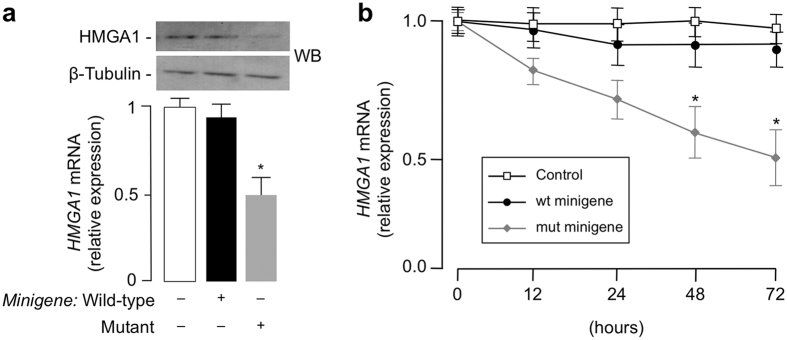
Effect of the HMGA1 minigene on HMGA1 expression.(a) HEK-293 cells were transiently transfected with 1 μg wild-type or mutant minigene construct, and endogenous HMGA1 mRNA and protein levels were measured 72 h later by qRT-PCR and Western blot (WB), respectively. Cropped blots are shown in the figure. Full-length WBs are presented in Supplementary Fig. S1. *P < 0.05 vs control (white bar). β-tubulin, control of protein loading. (b) Time course of HMGA1 mRNA abundance in HEK-293 cells, untreated (control, open square) or treated with wild-type (wt, solid circle) or mutant (mut, solid diamond) HMGA1 minigene. *P < 0.05 vs control. Data are mean ± standard error of the mean (s.e.m) of three independent experiments, each in triplicate.